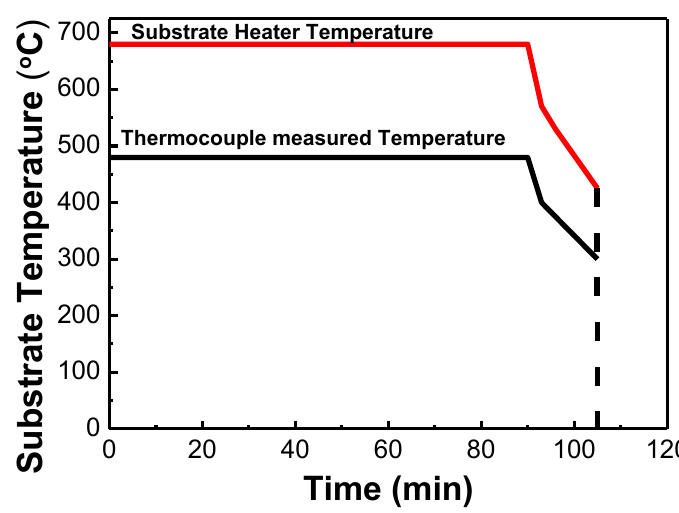
Figure 1. Growth temperature profile for Cu 2 ZnSnSe 4 (CZTSe) film deposition.